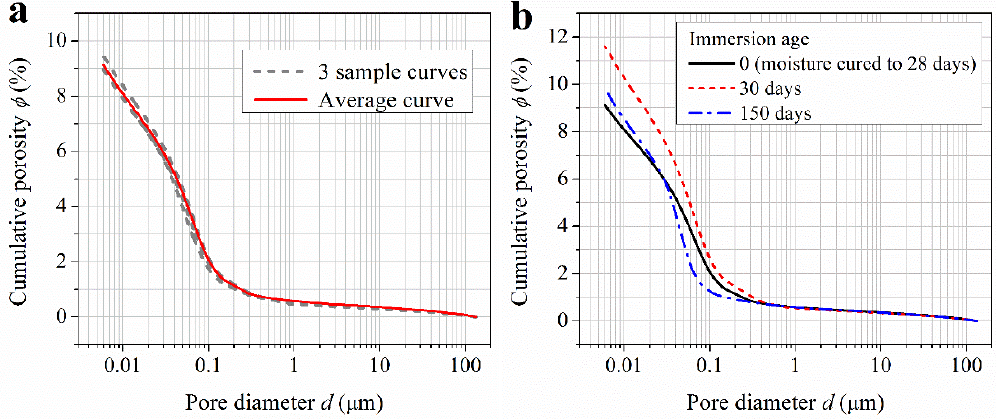
Figure 3. MIP cumulative porosity curves showing: ( a ) a curve averaged from three sample curves; and ( b ) changing of the pore structure of concrete as immersed in ultrapure